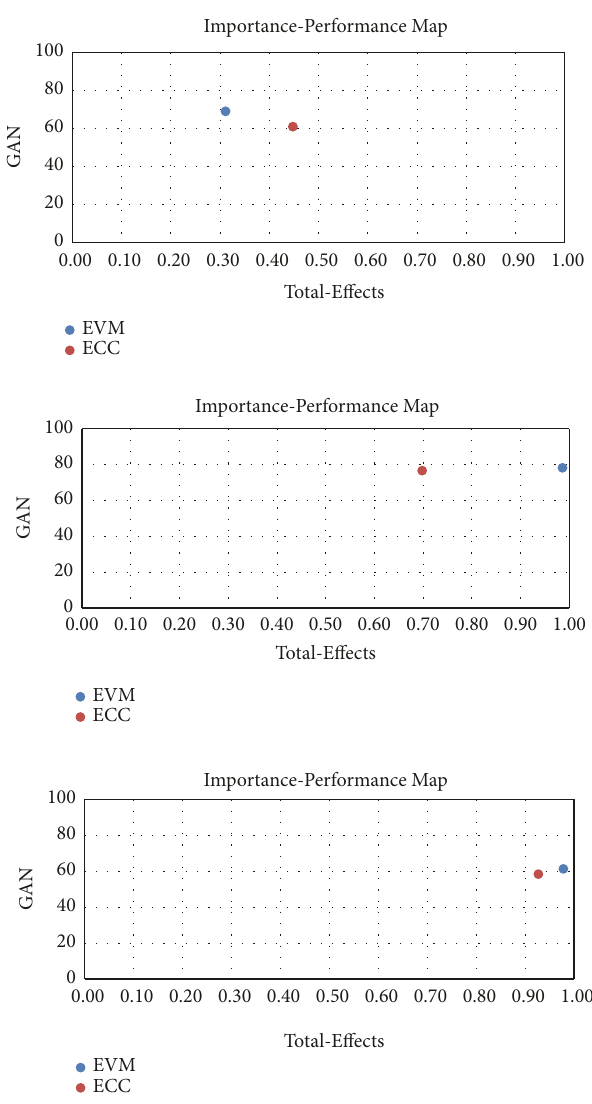
Figure 5: Importance-performance maps for k=1, k=2, and k=3.